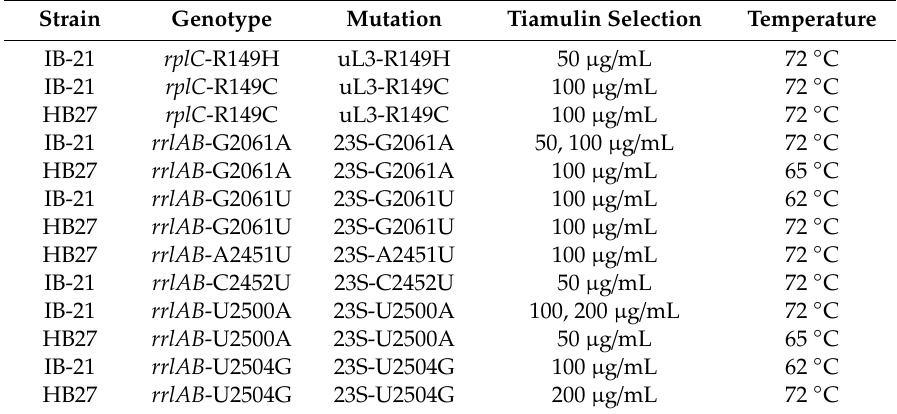
Table 1. Spontaneous tiamulin-resistant mutants identified in this study.